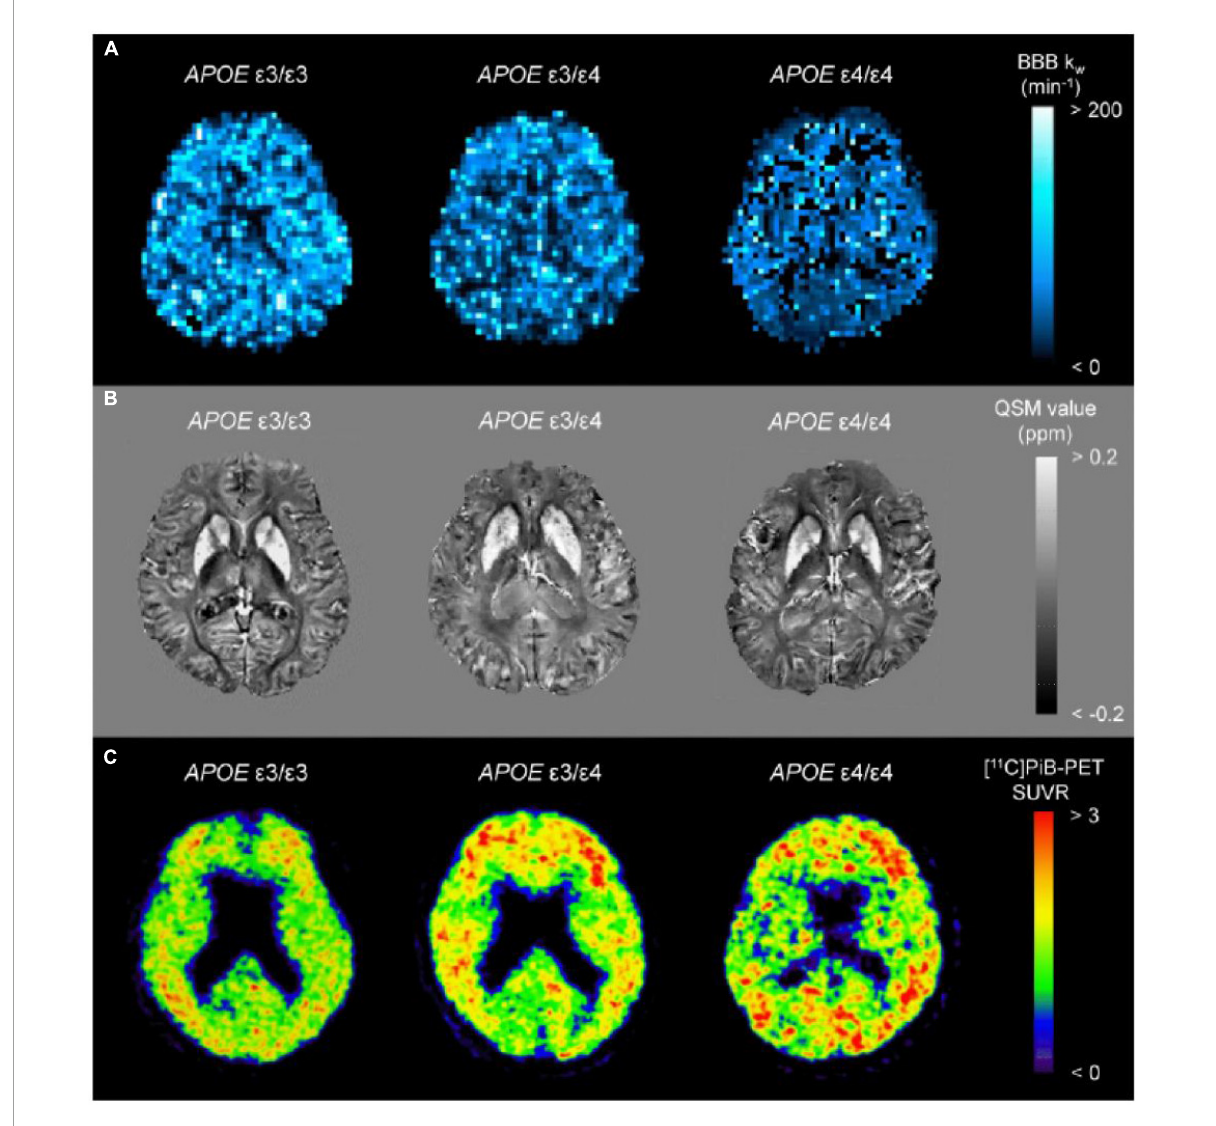
FIGURE1 Representative images from BBB k w map (A) , QSM (B) , and [ 11 C]PiB-PET SUVR (C) from a APOE ε 4 non-carrier ( ε 3/ ε 3), a heterozygote ( ε 3/ ε 4), and a homozygote ( ε 4/ ε 4). The k w map from the homozygote ( ε 4/ ε 4) displays the lowest k w values, which are associated with increased SUVRs of [ 11 C]PiB-PET. On the other hand, there were indiscernible differences for QSM among the groups. BBB, blood–brain barrier; PiB, Pittsburgh compound B; QSM, quantitative susceptibility mapping; SUVR, standard uptake value ratio (adapted with permission from Uchida et al.,